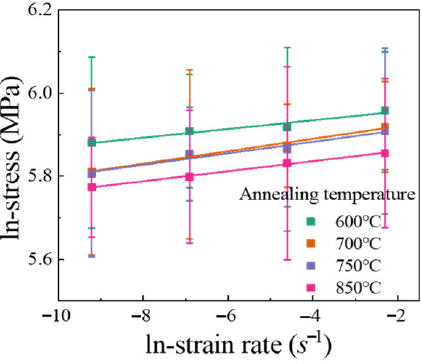
Figure 7. ln-stress vs. ln-strain rate curves of specimens with different annealing conditions.